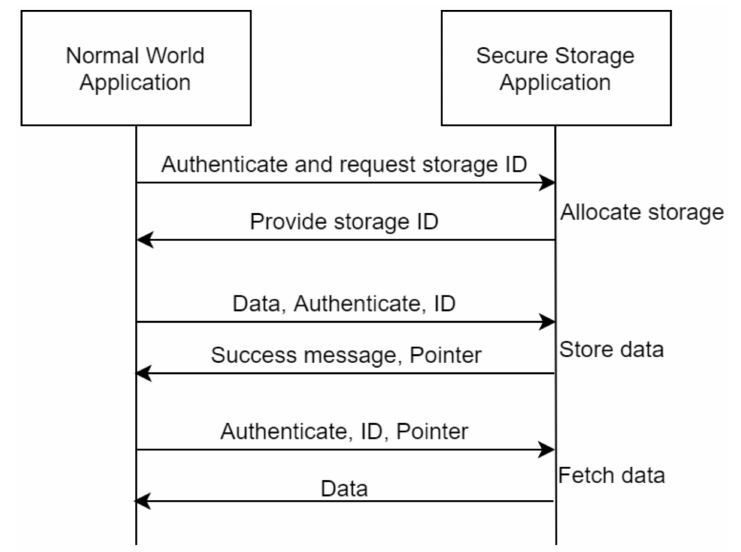
Figure 5. Abstract overview of the secure storage